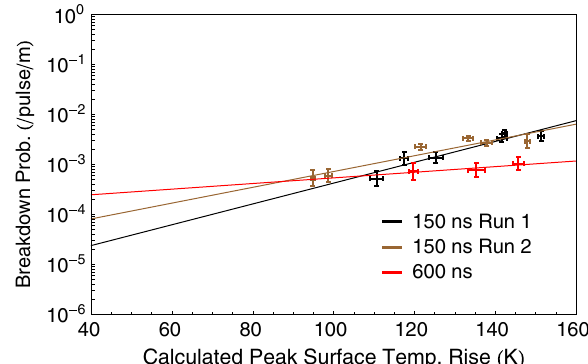
FIG. 19. Breakdown probability per pulse per meter of struc- ture vs peak surface temperature rise for PBG-E at pulse lengths of 150 and 600